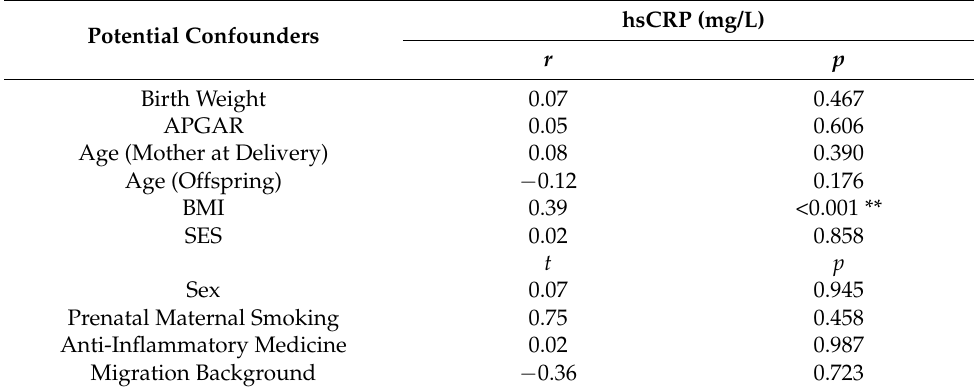
Table 2. Correlations and Mean Comparisons between the Offspring’s hsCRP Levels and Potential Confounders.